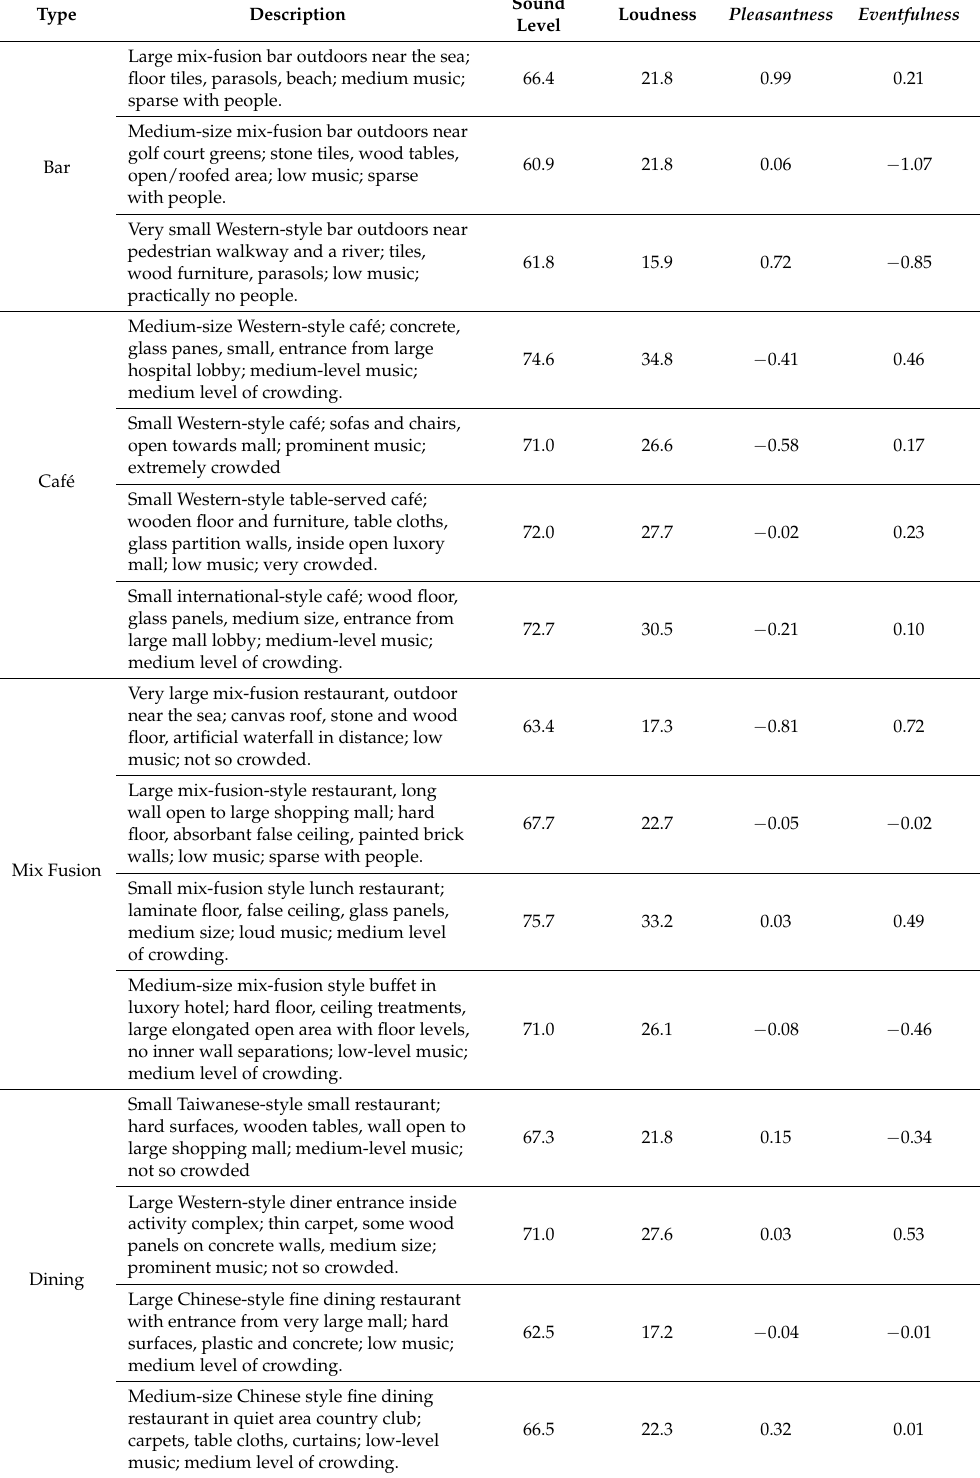
Table 2. Characteristics of restaurant soundscapes in Experiment 2. Units as in Table